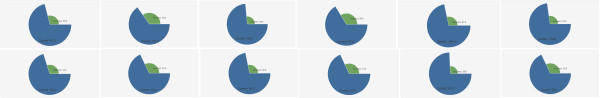
Results of all C45 classifiers.